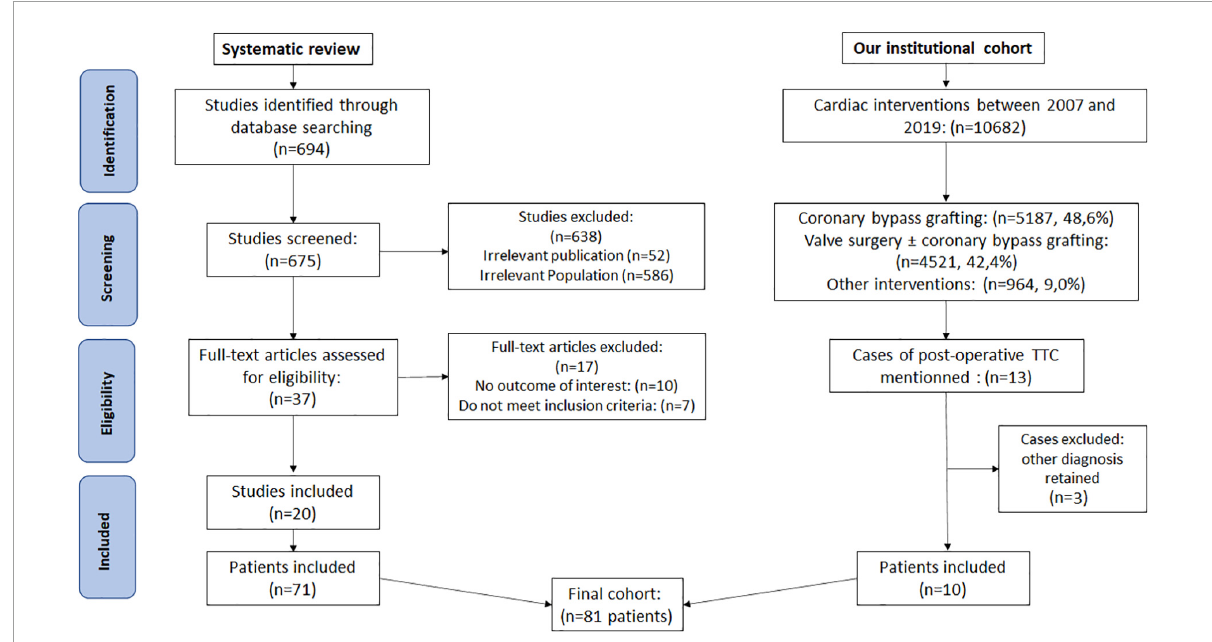
FIGURE1 PRISMA flowchart for the systematic review and flow chart of our institutional